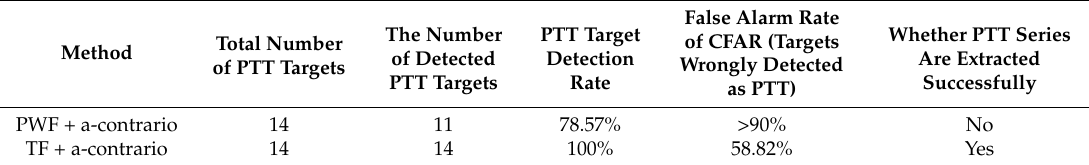
Figure 15. ( a ) filtered image based on TF analysis ( b ) point-like target detection results; ( c ) a-contrario extraction results; and ( d ) extraction results marked on the original image. Table 6. Results comparison of two methods in Experiment III.